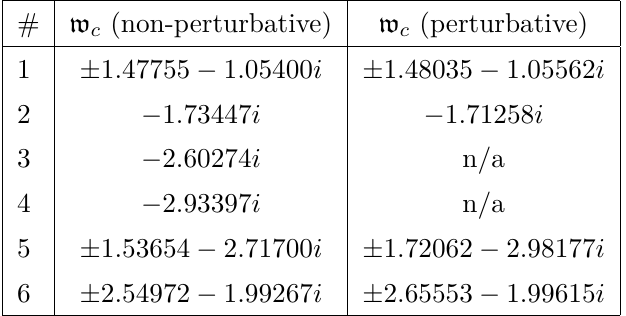
Table 2 . The six closest to the origin (in the complex w -plane) critical points for γ = 1 · 10 − 5 .